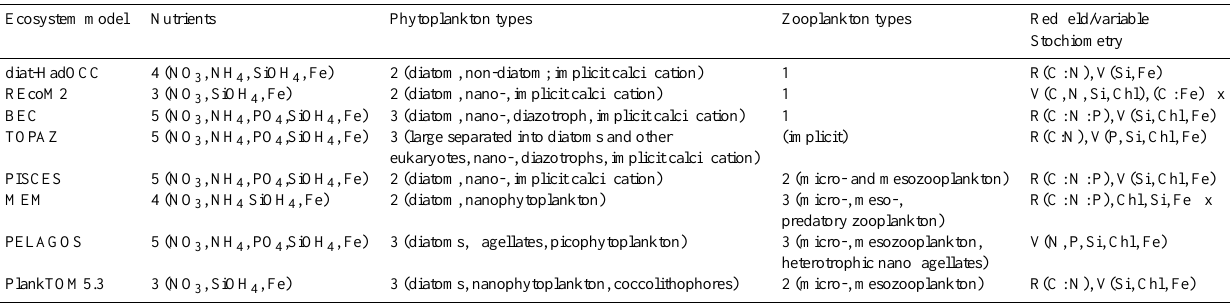
Table 2. Overview of ecosystem models used in this work, extended from Bopp et al. (2013). Ecosystem model